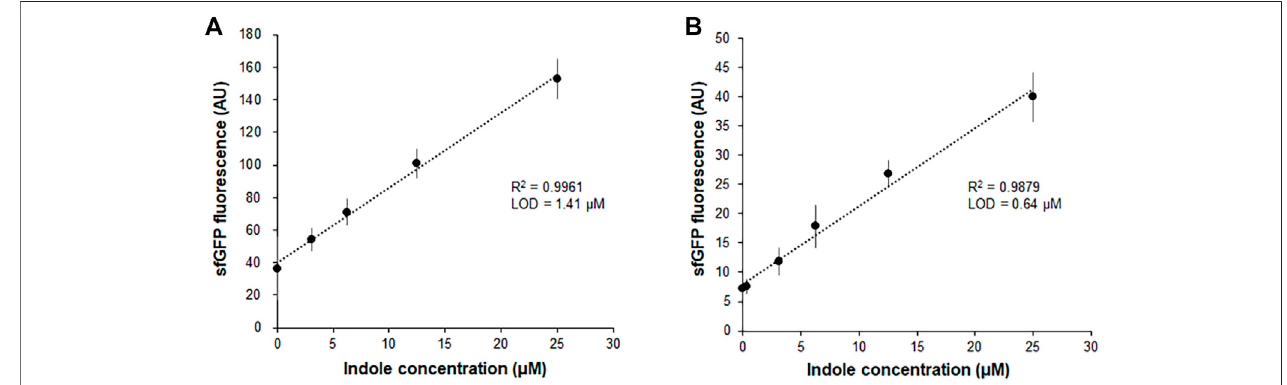
FIGURE 2 | Measurement of indole by the fl uorescence of sfGFP synthesized from Indole-CCFPS assay. Indole-CCPFS assay was performed with varying concentrations of indole using standard S12 extract (A) or dia fi ltered S12 extract (B) . The fl uorescence of the synthesized sfGFP was measured after 2 h incubation at 30 ° C. Measurements were performed in triplicate, and the error bars represent the standard deviations of three independent experiments.